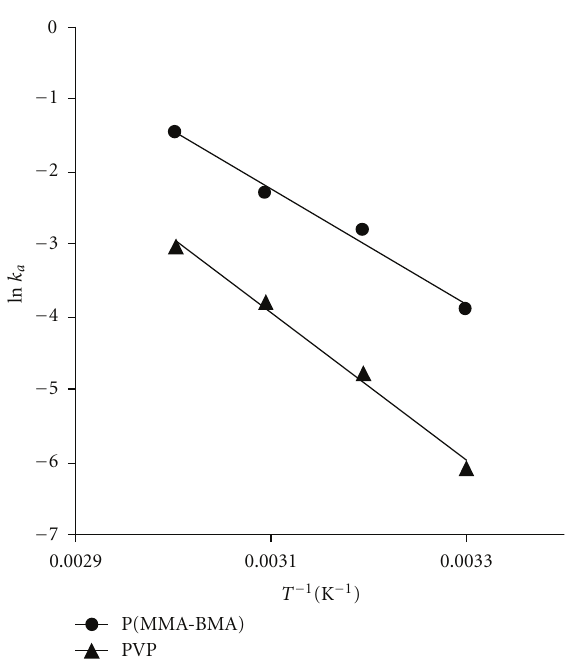
Figure 6: The Arrhenius plots for thermal bleaching of SPO-7OH in polymer matrices.